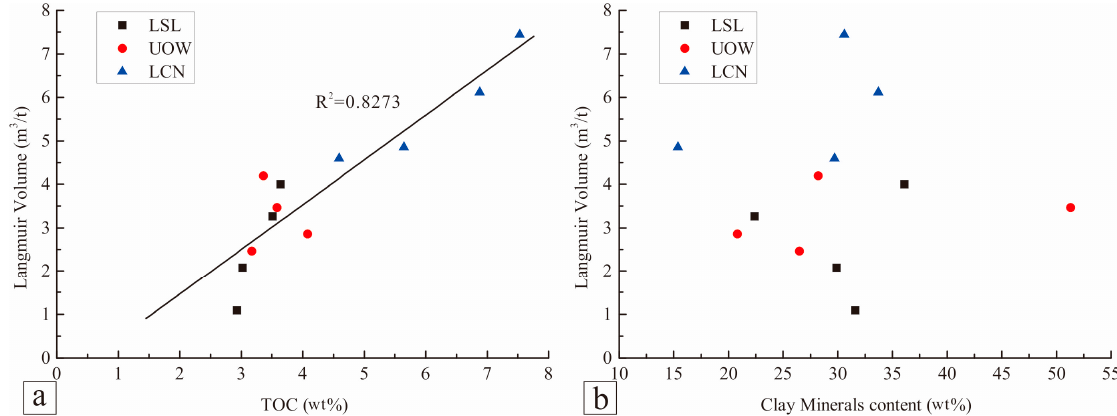
Figure 11. Relationships of ( a ) Langmuir volume vs. TOC content; and ( b ) Langmuir volume vs. clay mineral content.